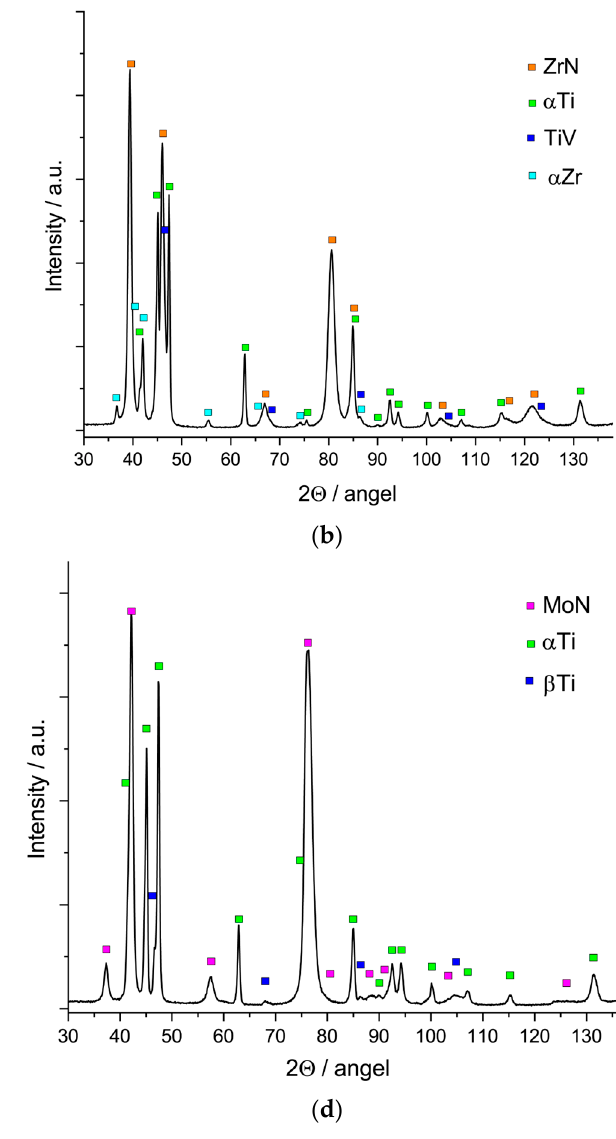
Figure 4. Diffraction patterns of the samples with the ( a ) Ti-TiN, ( b ) Zr-ZrN, ( c ) Cr-CrN, and ( d ) Mo- MoN coatings.